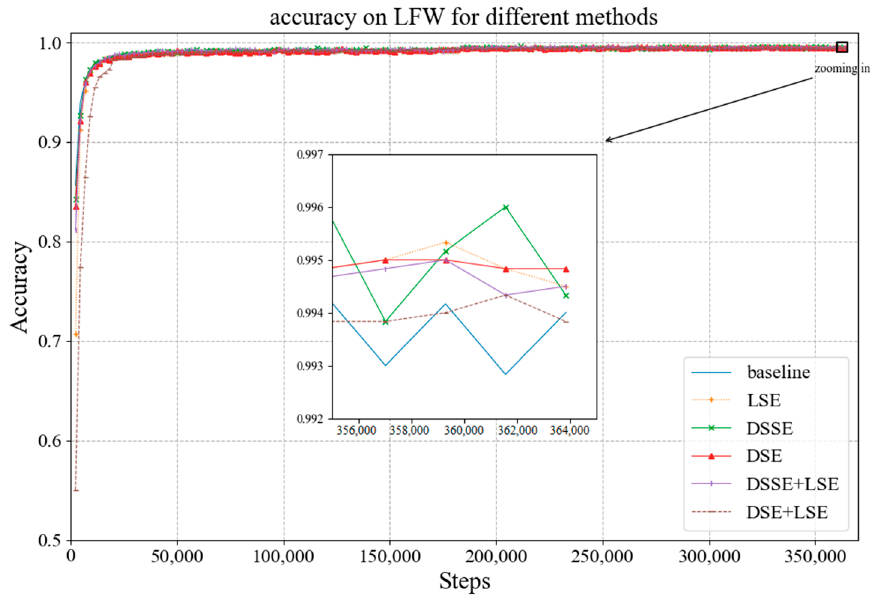
Figure 10. Accuracy curves of the models with different SE modules.